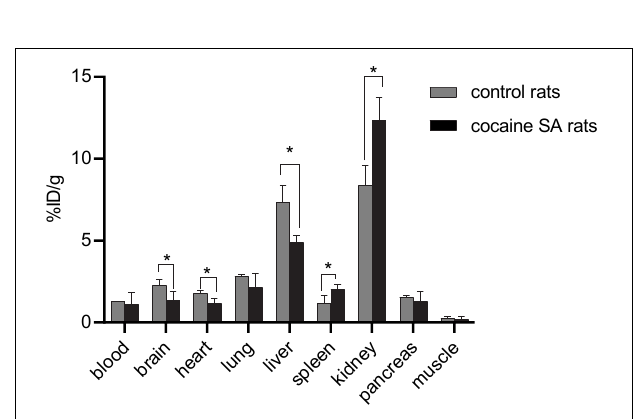
FIGURE 3 | Post-PET biodistribution profile of [ 11 C]MPC-6827 in control and cocaine SA rats ( n = 4/sex); * p ≤ 0.05, ** p = 0.0038.